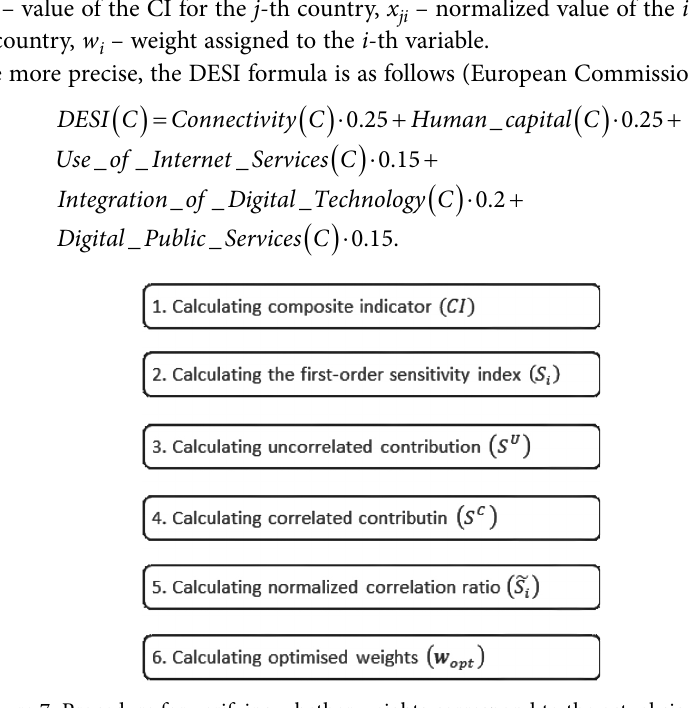
Figure 7. Procedure for verifying whether weights correspond to the actual